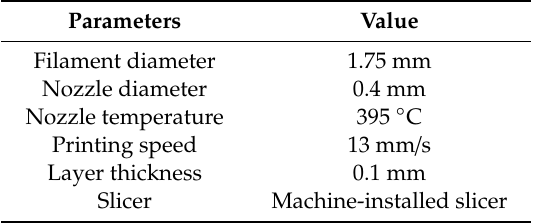
Figure 6. CT of a magnified dental implant produced with Apium HPP155 (( a ) is the printed implant, ( b – d ) are micro CTs of the sample). Table 4. The parameters used for dental implant printed with Apium HPP155 printer. Table 4. The parameters used for dental implant printed with Apium HPP155